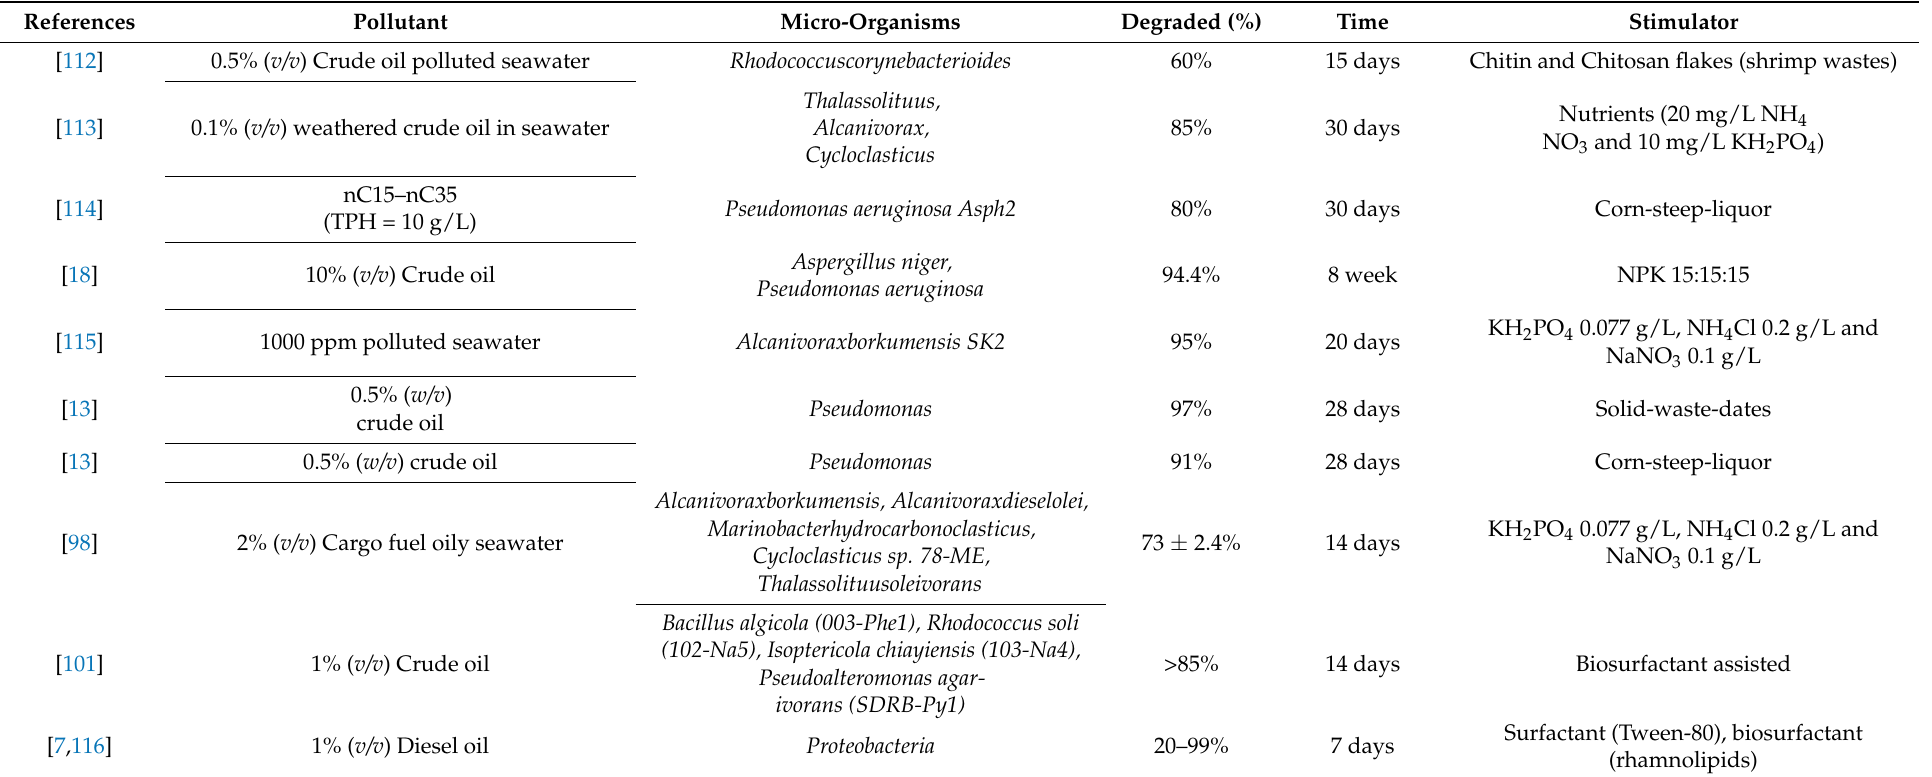
Table 6. List of selected studies for degradation of petroleum hydrocarbons using bioaugmentation–biostimulation